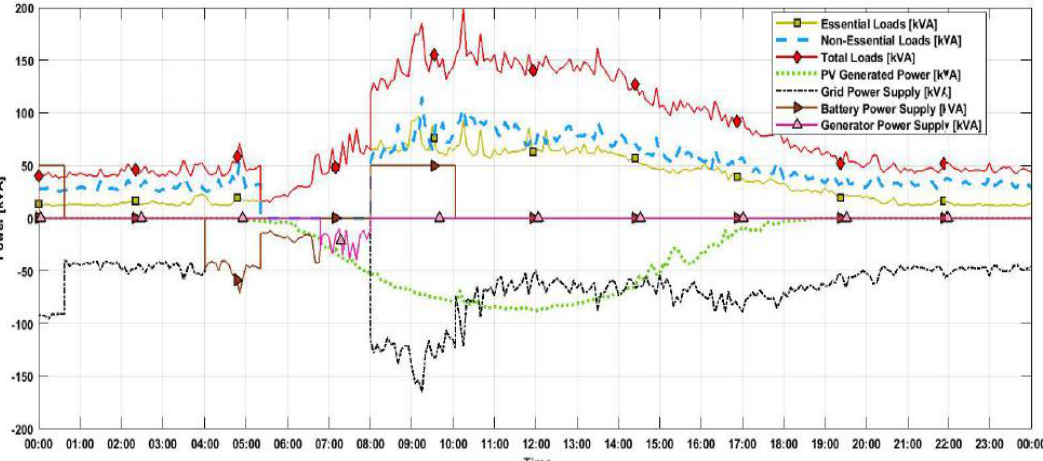
Figure 18. The behavior of MCAST micro-grid integrated with a 150 kWh BESS and 150 kVA diesel generator during a 4-h power cut.